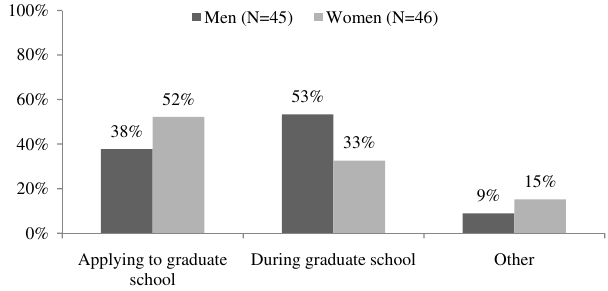
FIG. 3. When graduate students chose to pursue physics education